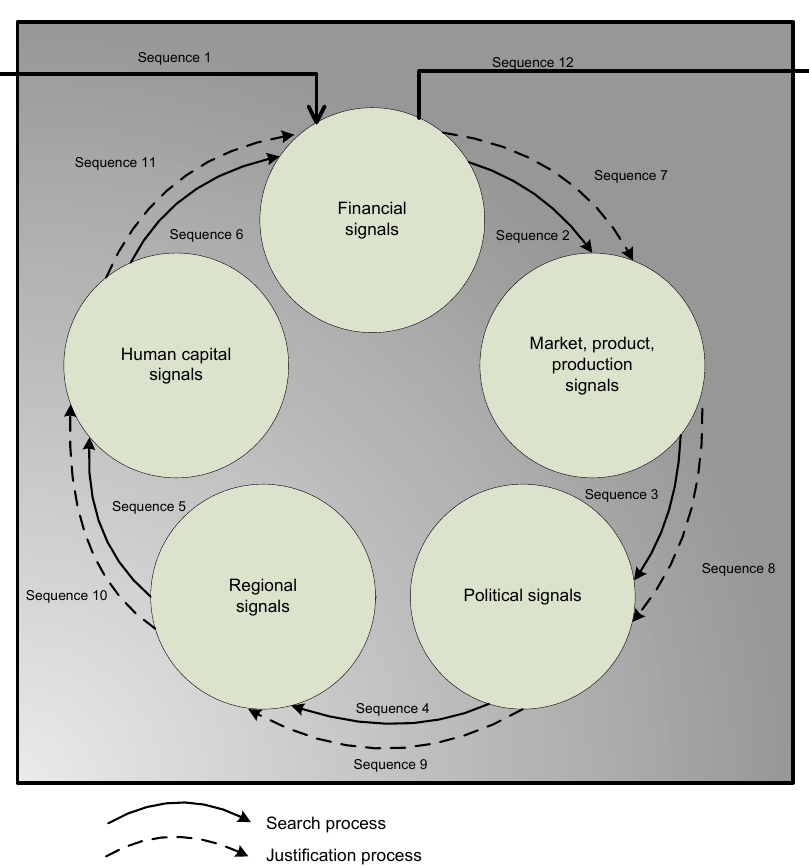
Figure 1. Process model of signal use and decision-making.